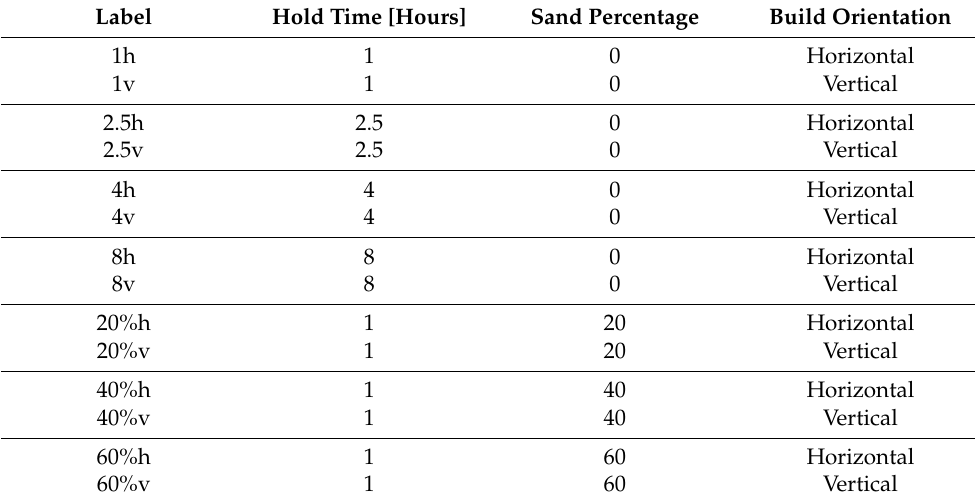
Table 2. Labelling of each batch of four specimens according to each study variable.